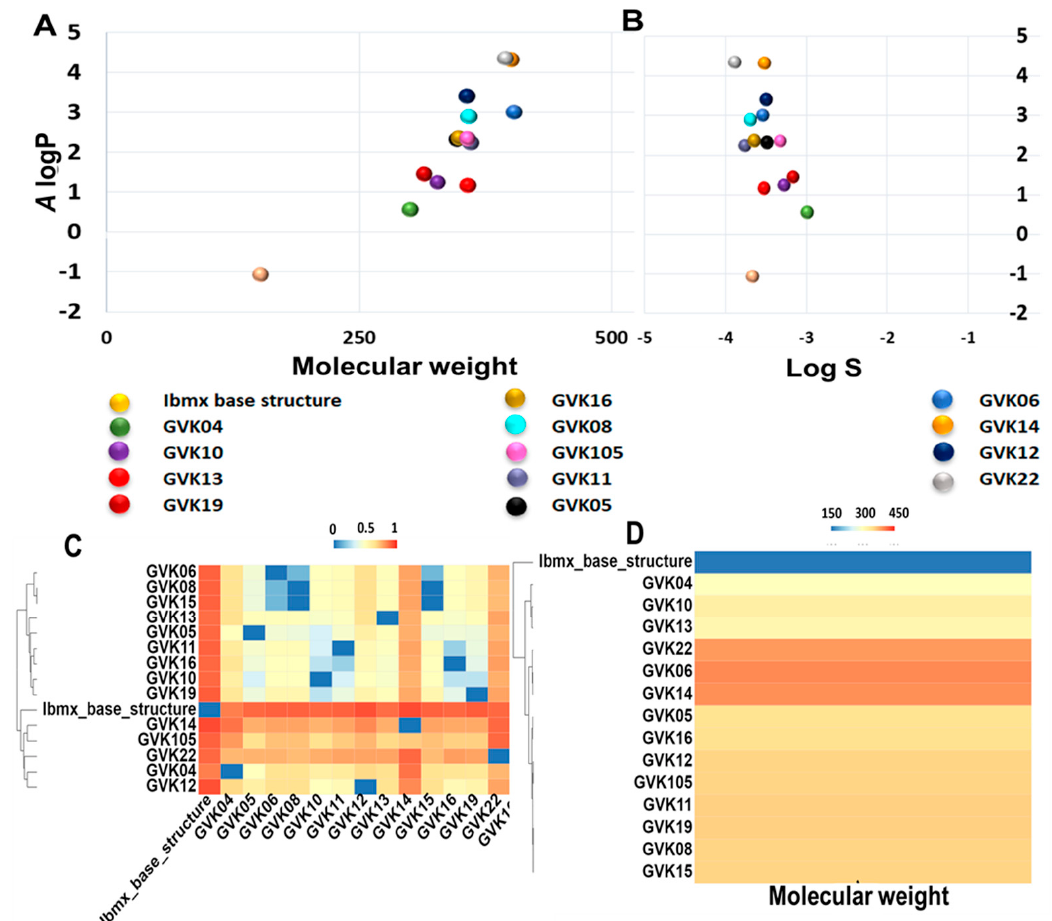
Figure 3. Distribution of chemical properties on xanthine analogs. Panel ( A ): Chemical space distribution of xanthine analogs. Chemical space is defined by molecular weight (MW) as the X -axis and Ghose–Crippen Log K ow ( A log P ) as the Y -axis. Panel ( B ): Ghose–Crippen Log K ow ( A log P ) (lipophilicity) versus aqueous solubility (log S). Panel ( C ): The molecular weight distribution of the xanthine analogs used in this study. Compounds with similar molecular weight are closer in color. Panel ( D ): Tanimoto similarity index for all xanthine analogs used in this study; colors closer to red in the heat map mean that the compounds are more similar, and colors closer to dark blue mean that the compounds have higher